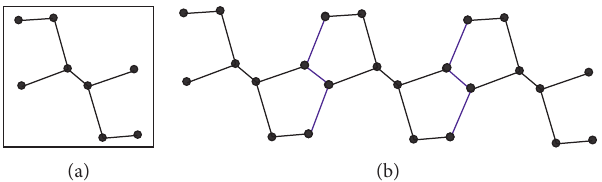
Figure 2: (a) The M-carbon unit cell. (b) Chain of three units and units connected by blue edges.